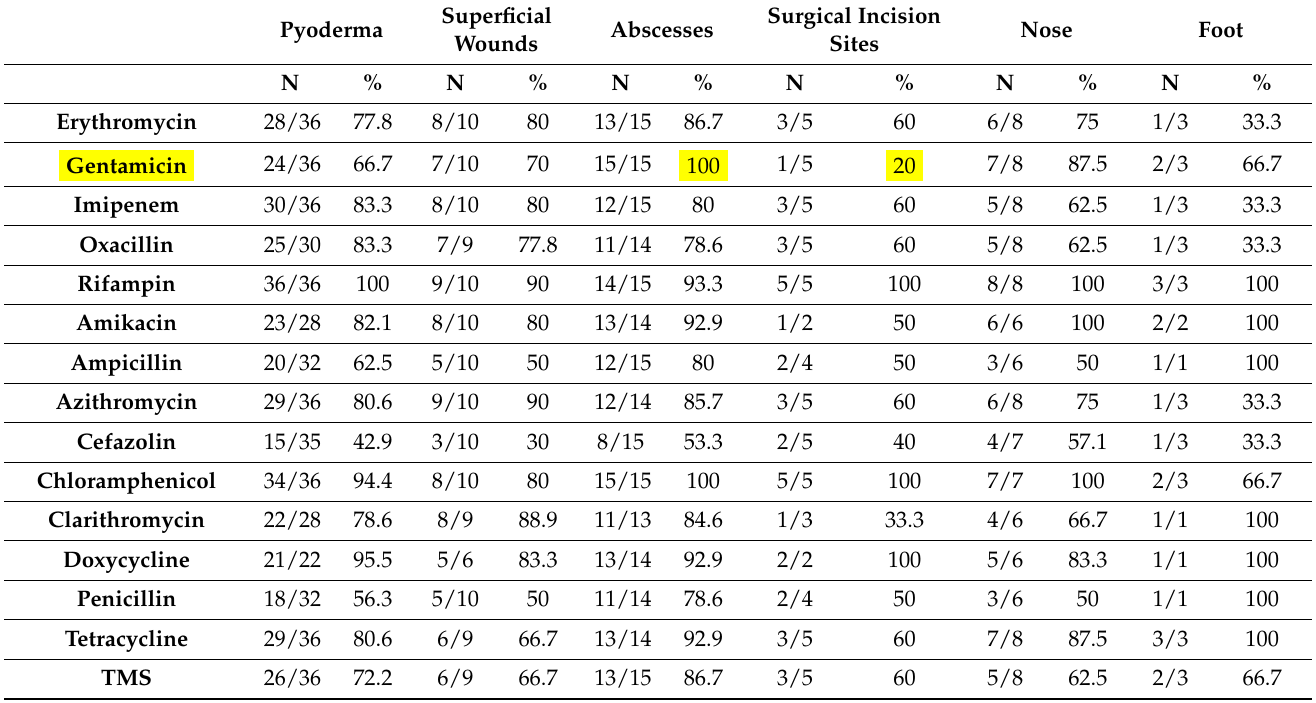
Table 1. Susceptible Staphylococcal species for each sample collection